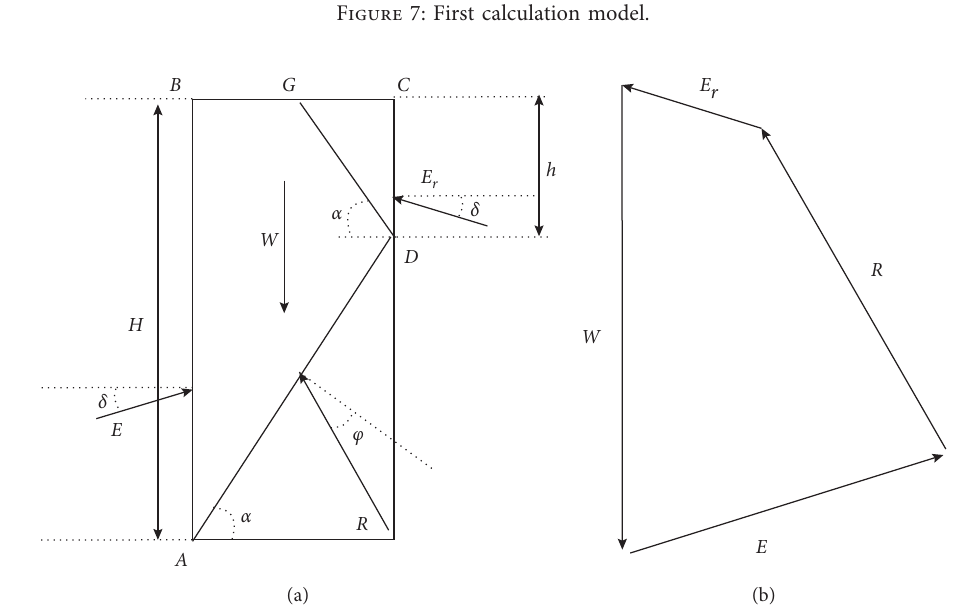
Figure 8: Second calculation